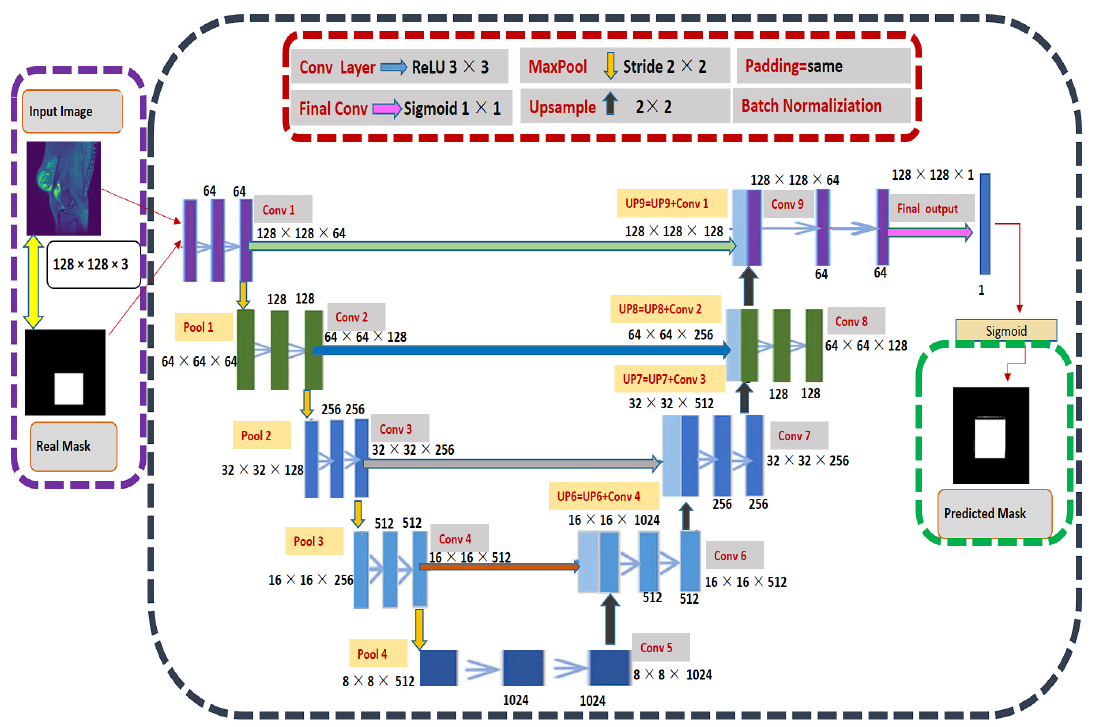
Figure 5. The complete process of modified U-Net Model with eight convolutional layers, four maximum pooling and upsample layers training and prediction.